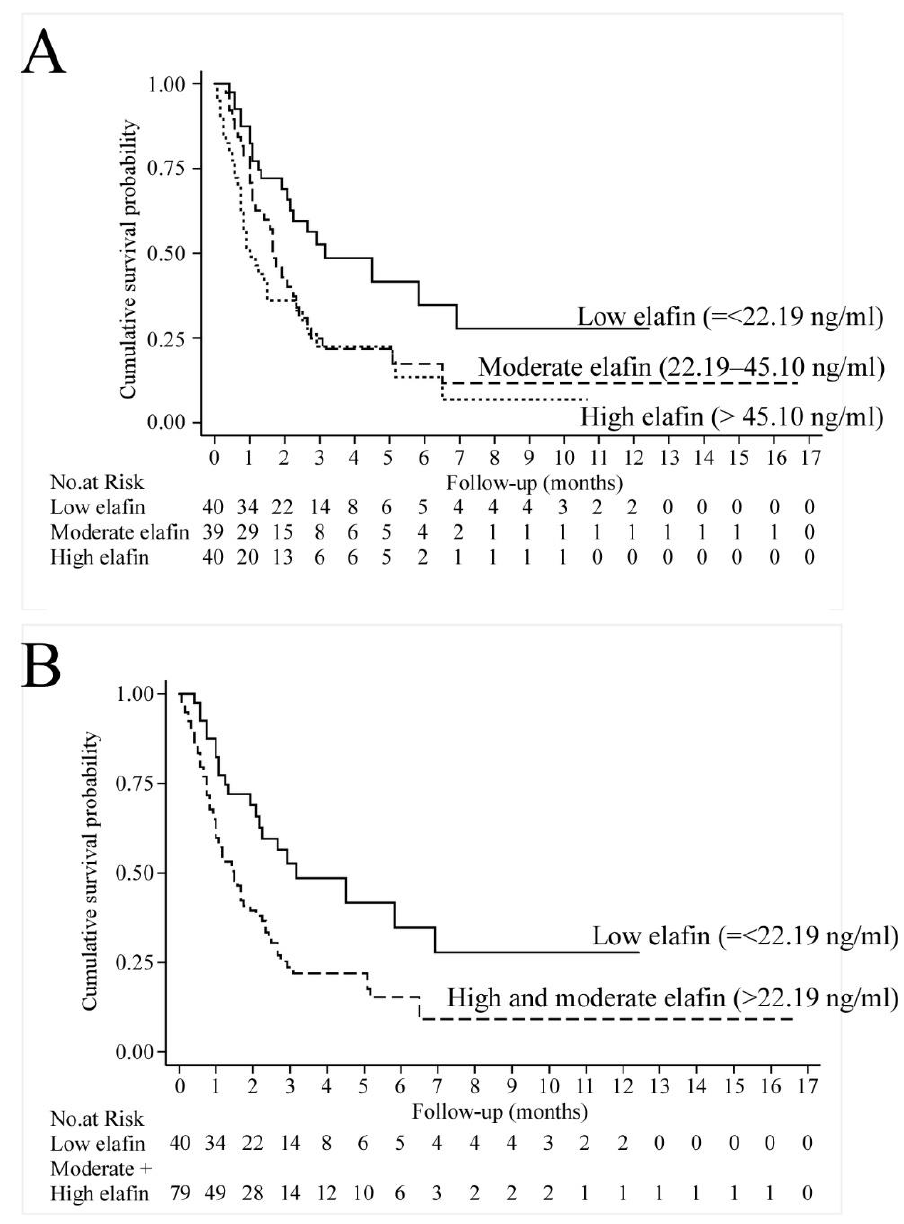
Figure 1. High levels of serum elafin were associated with poor prognosis in 119 stage I–IIIA esoph- ageal squamous cell carcinoma patients. ( A ) Kaplan–Meier analysis of serum levels divided by ter- tile cut-off points (Log-rank test, p = 0.004); ( B ) Kaplan–Meier analysis of serum levels dichotomized by 1owest tertile cut-off point (Log-rank test, p = 0.002). Table 1. Baseline characteristics of the 119 stage I-IIIA ESCC